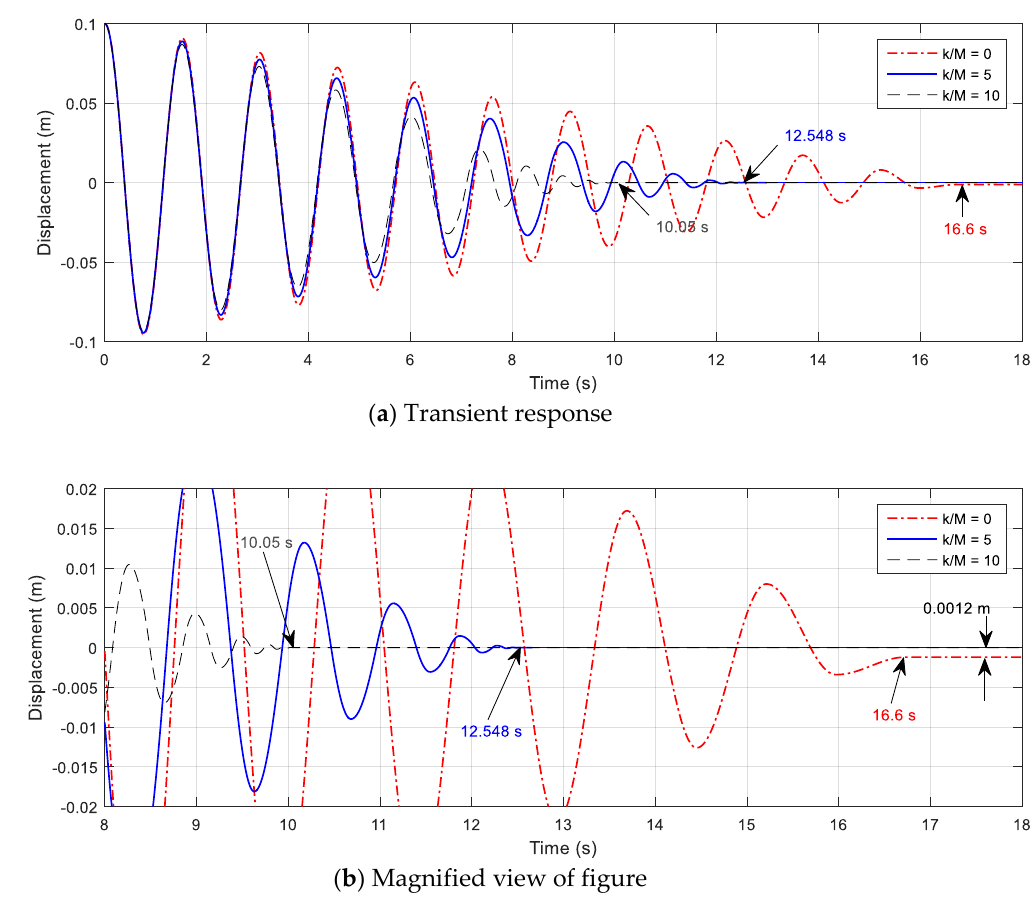
Figure 3. Transient responses of the superstructure according to change of k / M in case of ς r = 0 .